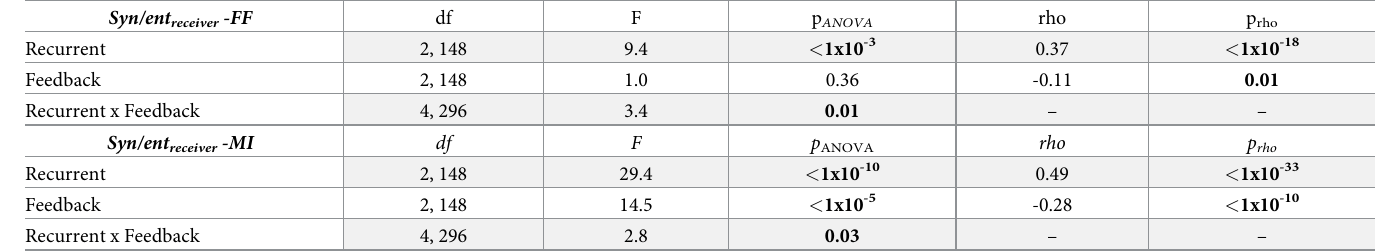
Table 2. Relationships between residual normalized synergy and recurrence and feedback, after regressing out potential confounding covariates: strength of feed- forward edge weights (Syn/ent receiver -FF), and mutual information between senders (Syn/ent receiver -MI). Columns 1–3 ( df , F , p ANOVA ) show the results of a repeated measures ANOVA for the residual normalized synergy predicted by the number of recurrent and feedback edges. Columns 4–5 ( rho , p man rank correlations between residual normalized synergy and the number of recurrent and feedback edges. P-values significant at the α = 0.05 level are in bolded